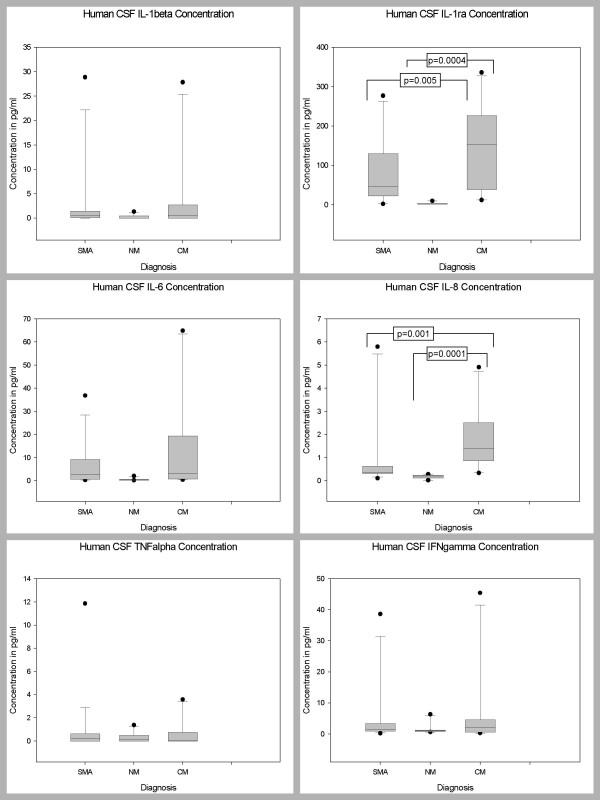
Postmortem CSF biomarker levels of IL-1β, IL-1ra, IL-6, IL-8, TNF-α, and IFN-γ in children dying with CM, SMA, NM causes. CM, cerebral malaria; SMA, severe malarial anemia; NM, non-malaria. Box plots representing medians with 25th and 75th percentiles, bars for 10th and 90th percentiles, and points for outliers of biomarker concentrations. Only statistically significant P values after Bonferroni adjustment for the other biomarkers are shown.